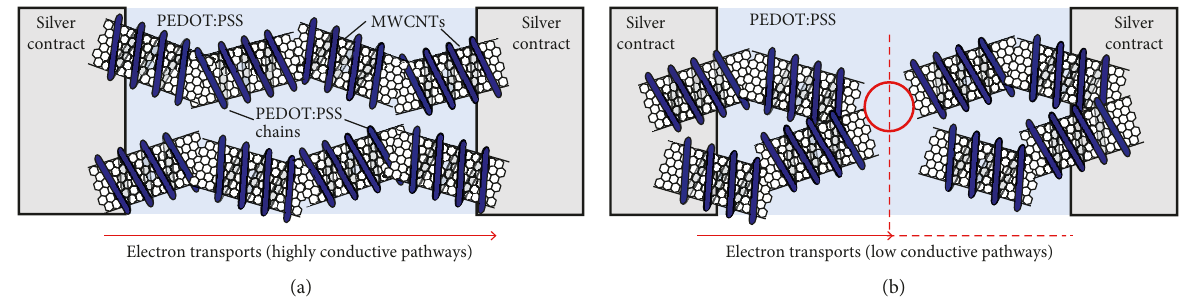
Figure 13: Schematic illustration of conductive pathways in electron transports for (a) inkjet-printed MWCNT-PEDOT:PSS networks and (b) drop-casted MWCNT-PEDOT:PSS